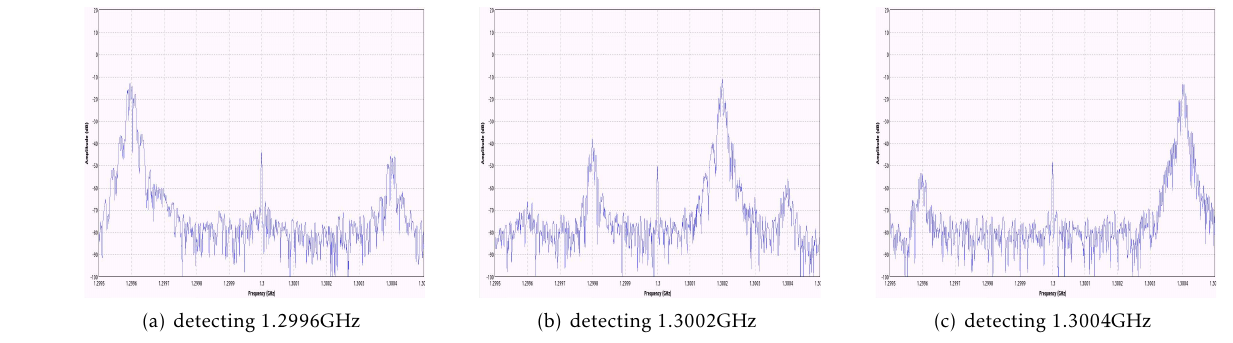
Figure 11. Primary signals are detected on three channels.